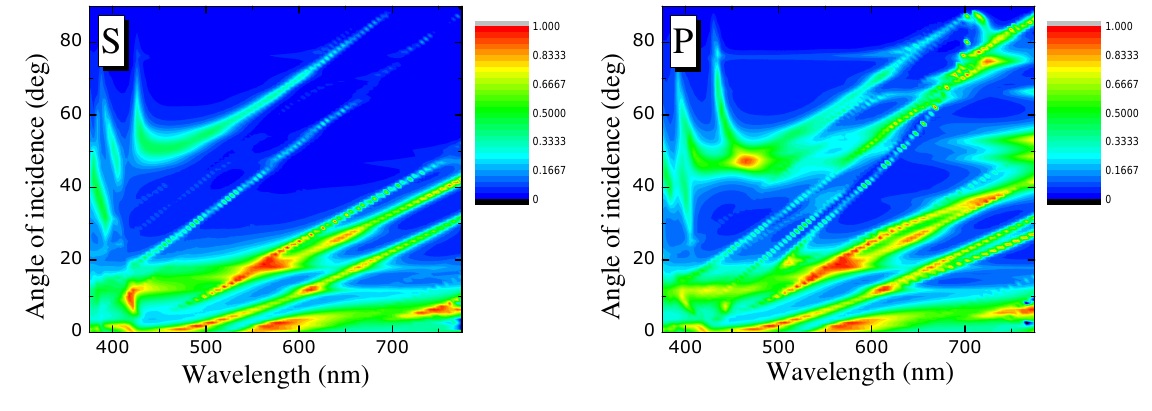
Figure 5. The same as Figure 4, but for a silver substrate.